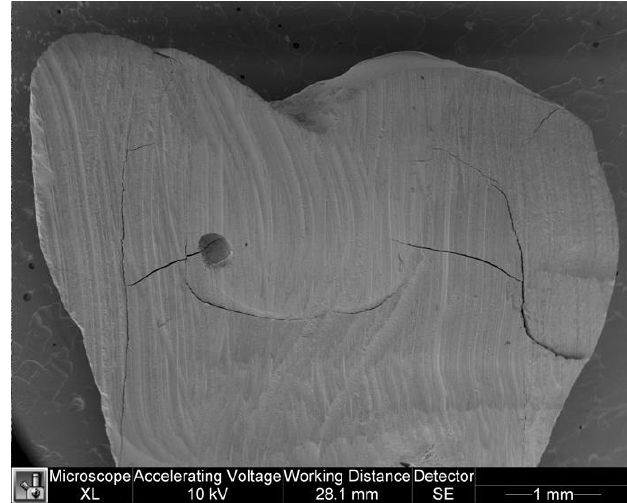
Figure 12. Voids in a specimen of the control group. Table 9. Restoration time data in the study group.